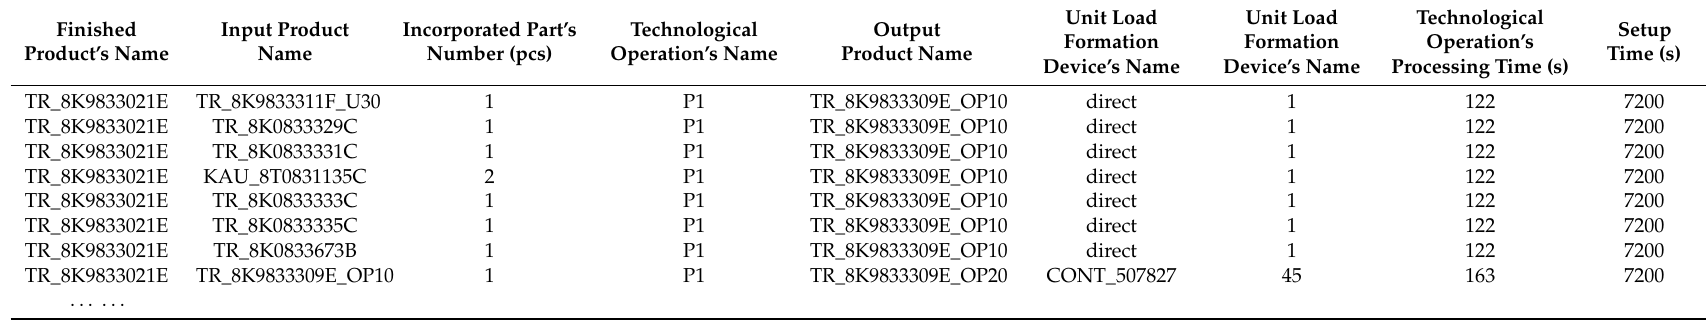
Table 7. Manufacturing data table.